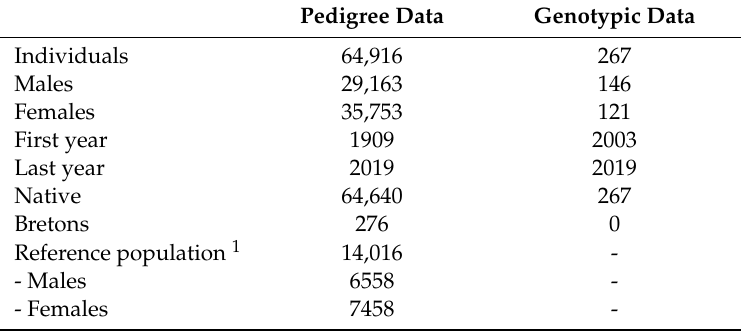
Table 1. Structure of pedigree and genotypic data used in the